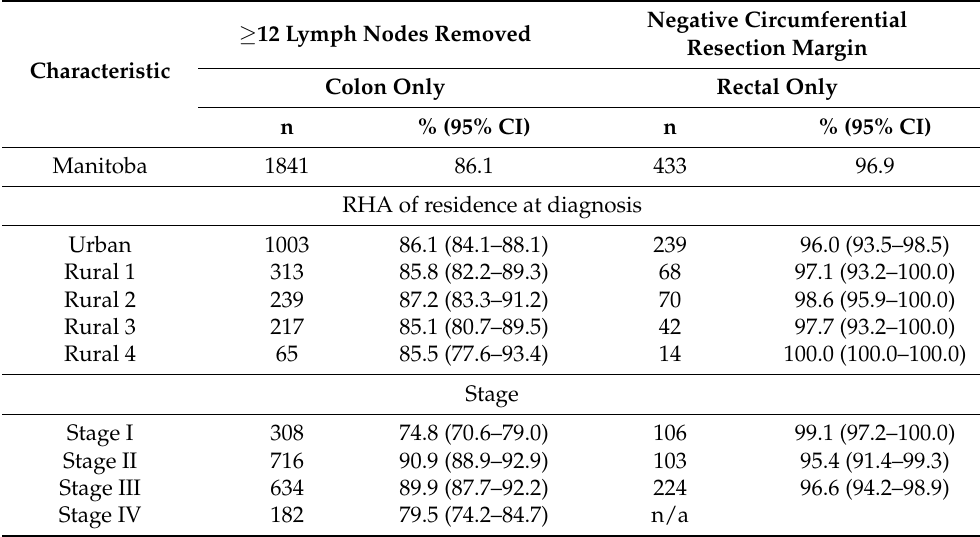
Table 5. ≥ 12 Lymph Nodes Removed and Negative Circumferential Resection Margin by Regional Health Authority of Diagnosis and Stage,